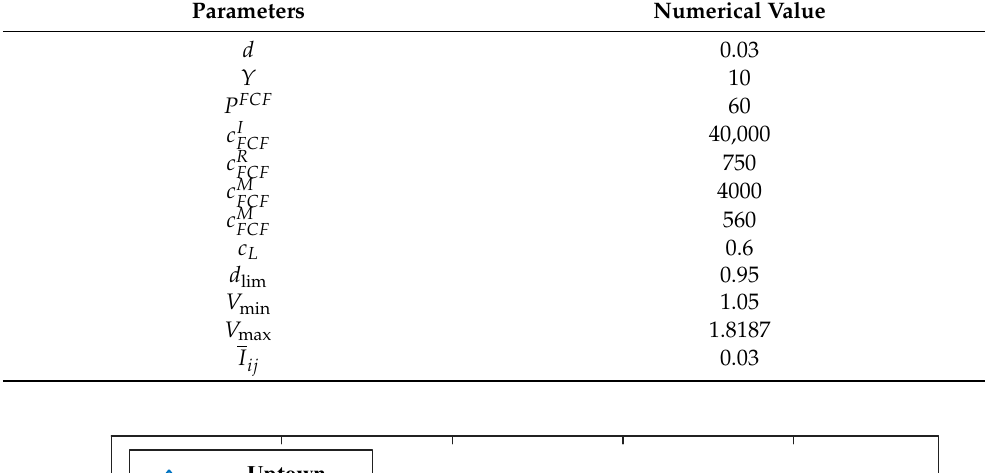
11 Table 2. Example parameter values. Parameters